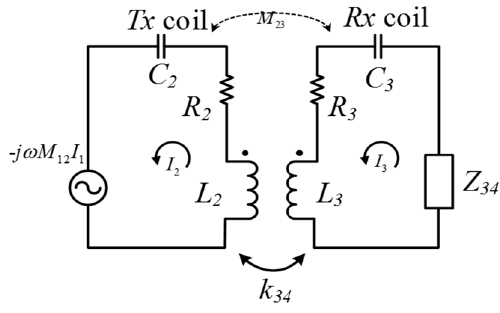
Figure 3. Simplified circuit model of the four-coil WPT system.